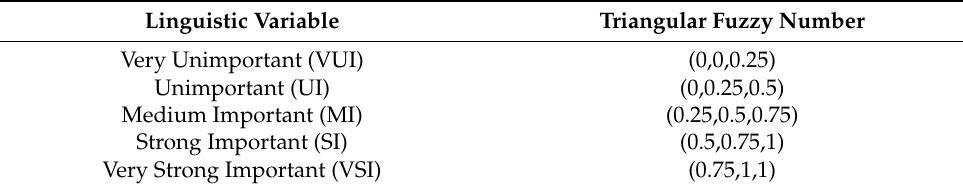
Table 3. Fuzzy linguistic weights for the relative importance of risk